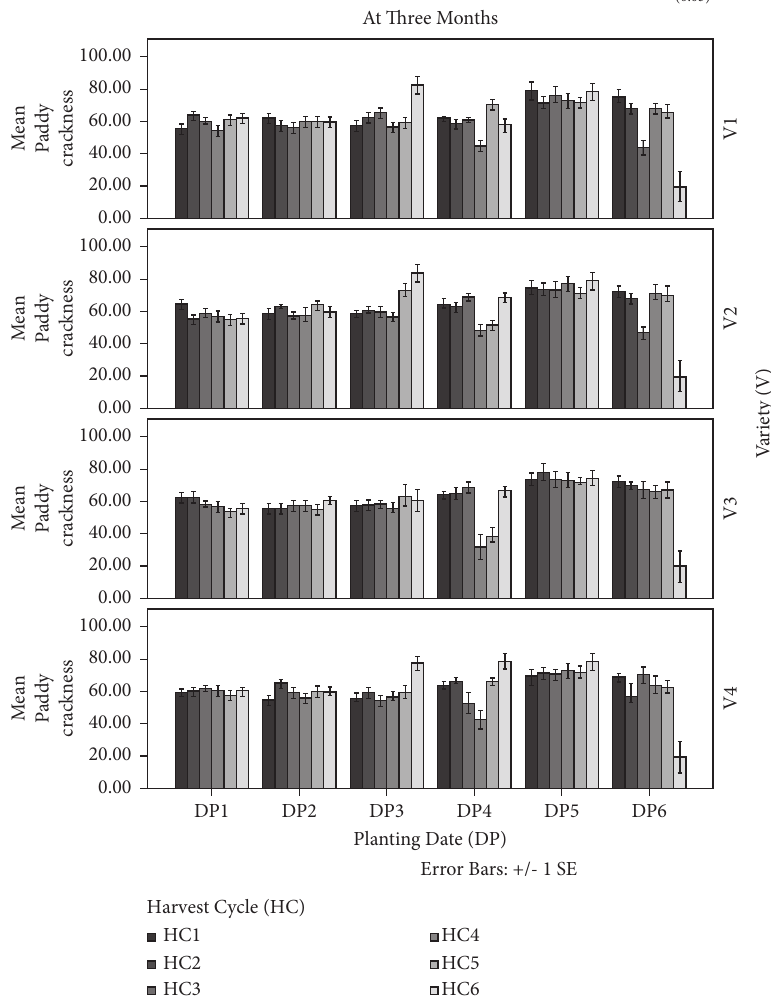
Figure 7: Effect of planting date, variety, and harvest cycle on paddy crackness at three months of storage in the Northern Savanna Agroecological Zone of Ghana. Bars represent the SEM. DP1 � first planting, DP2 � second planting, DP3 � third planting, DP4 � fourth planting, DP5 � fifth planting, DP6 � sixth planting, V1 � Agra, V2 � Gbewaa, V3 � Exbaika, V4 � Perfume Irrigated, HC1 � first harvest, HC2 � second harvest, HC3 � third harvest, HC4 � fourth harvest, HC5 � fifth harvest, and HC6 � sixth